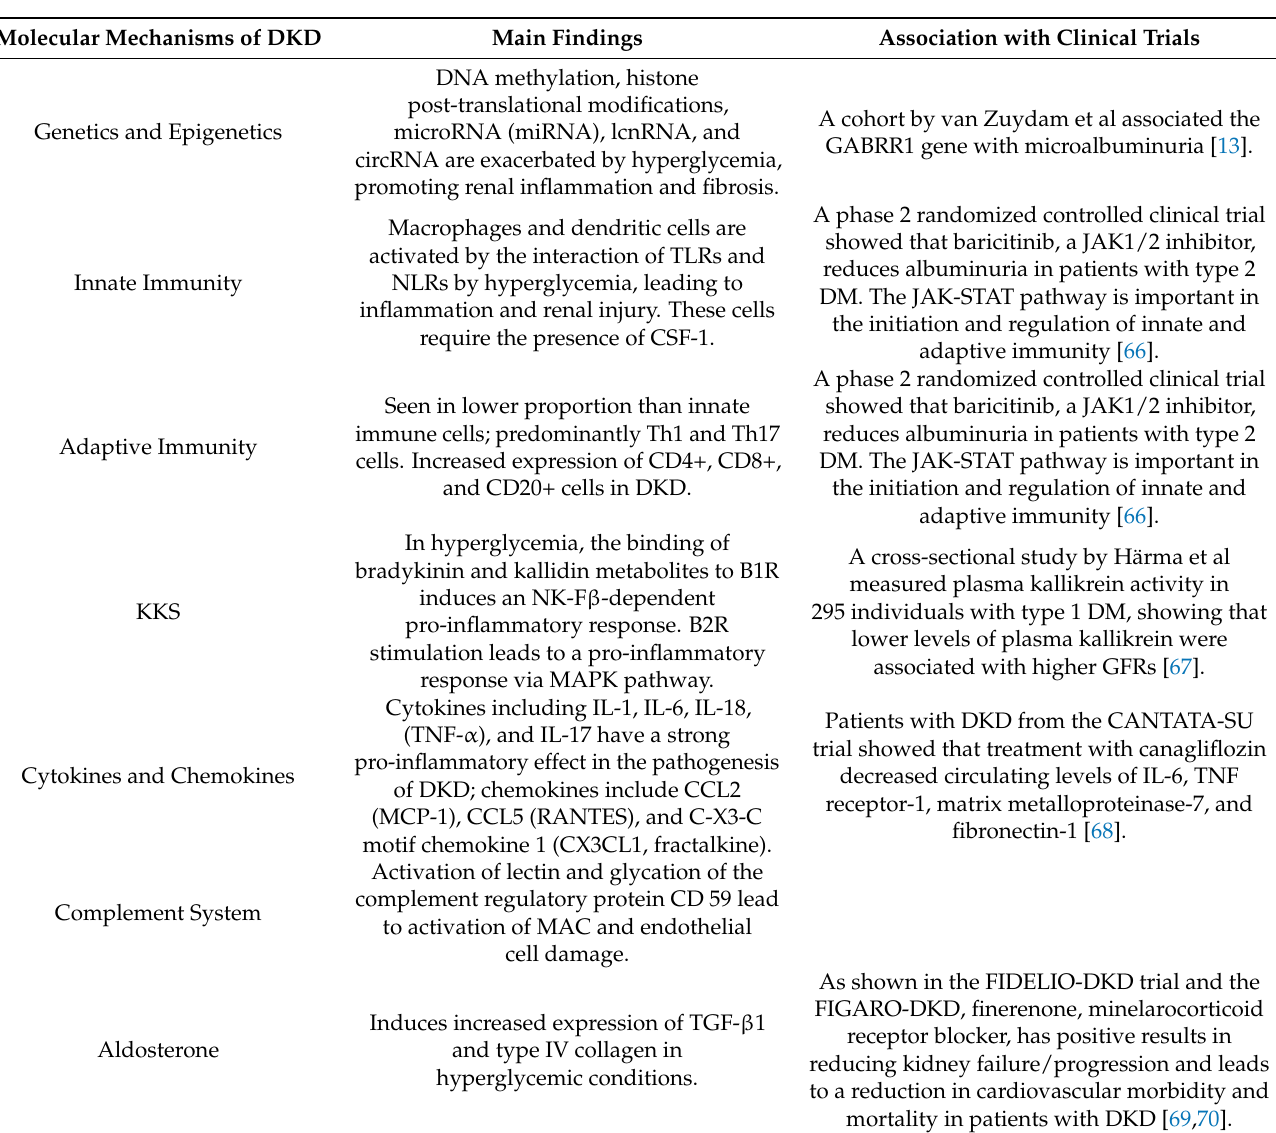
Table 3. Main molecular mechanisms of DKD and their main findings summarized, as well as their association with published clinical trials